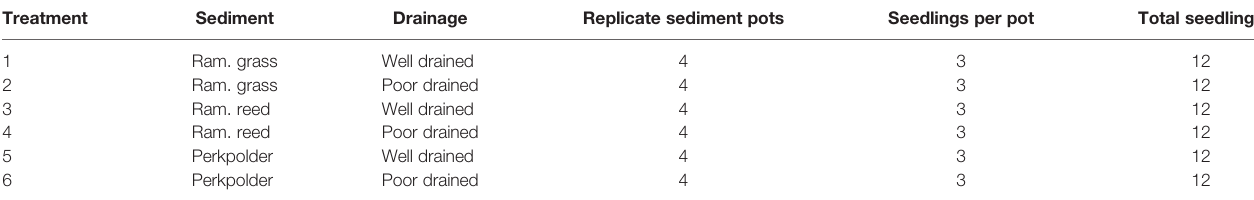
TABLE 2 | Treatment details in the mesocosm